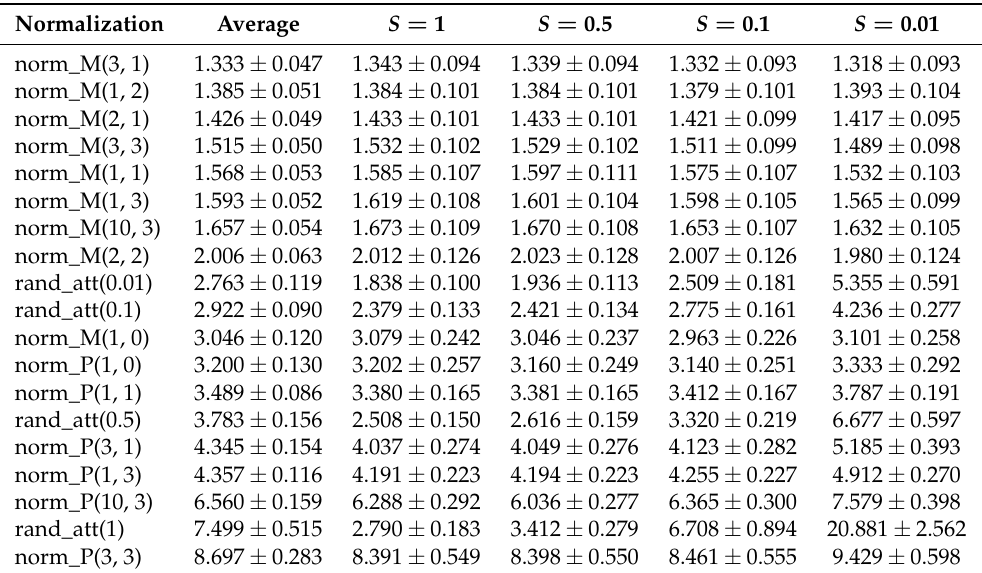
Table A4. Mean F 0 errors on mel spectrograms rescaled by the factor S . All errors in Hz with a 95% confidence